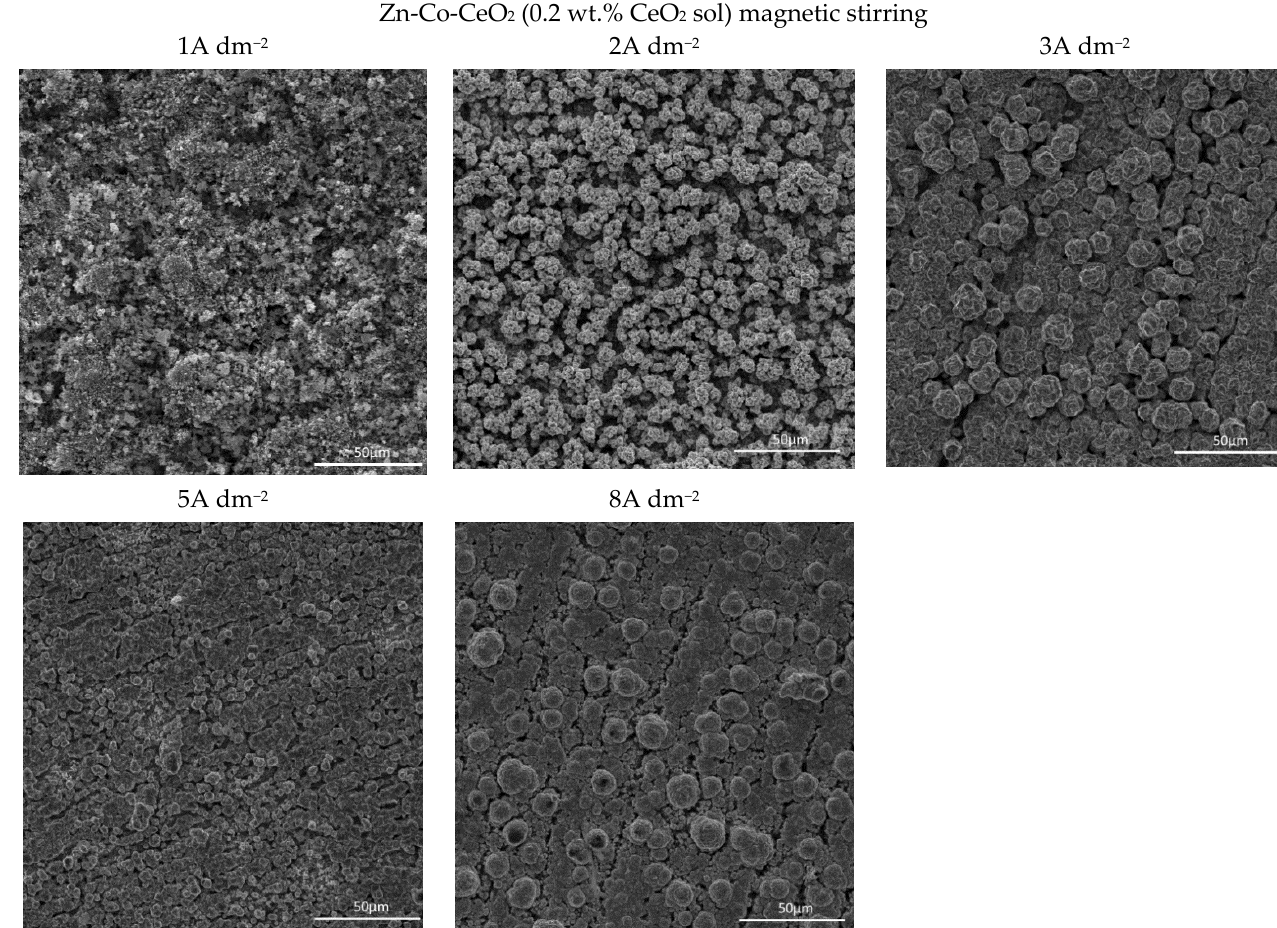
Figure 7. Morphology of the Zn-Co-CeO 2 composite coatings deposited at different current densities from the plating solution with 0.2 wt.% ceria sol.